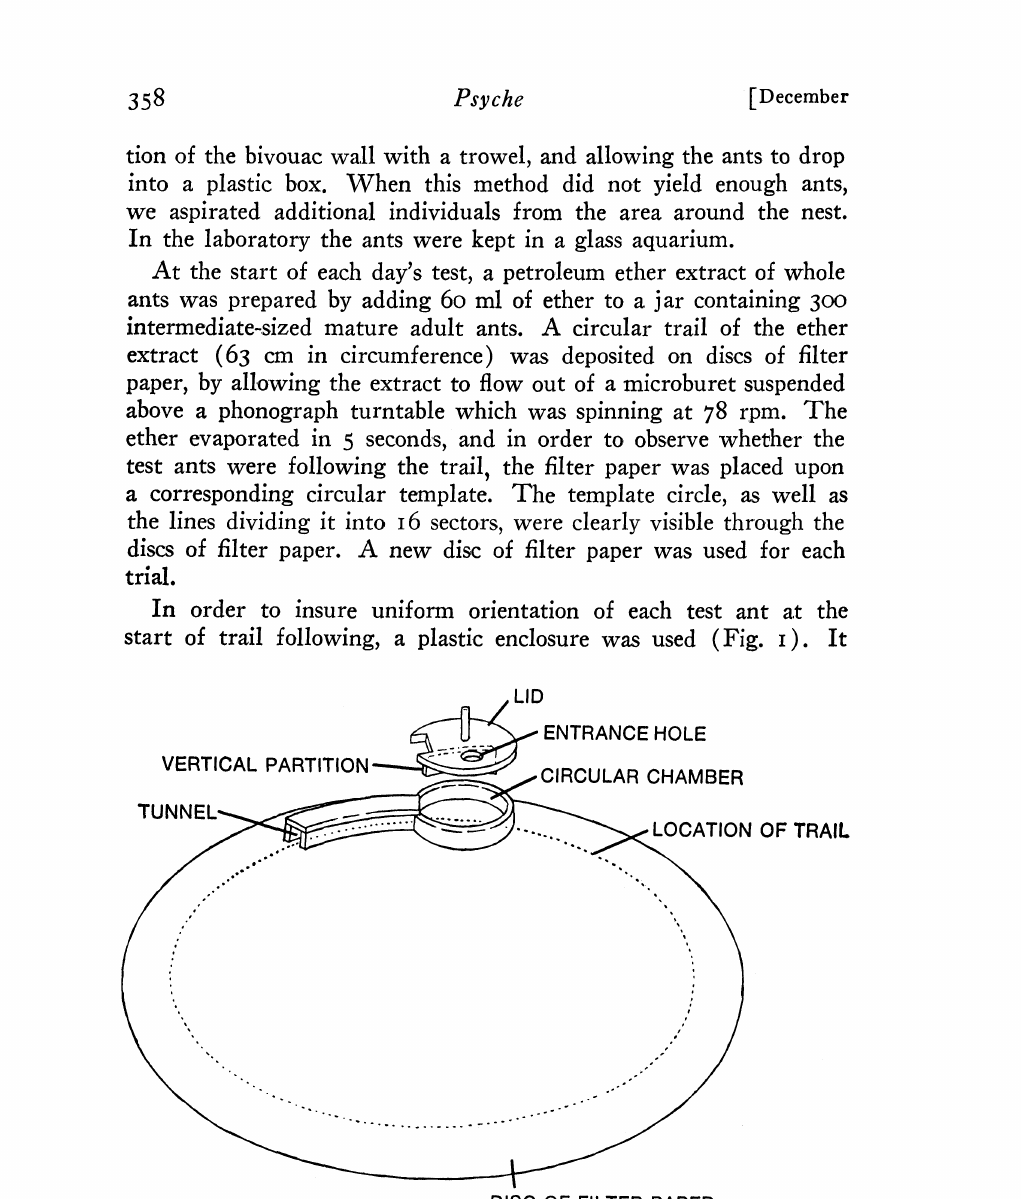
Fig. 1. Apparatus used to insure that all test ants initially orient to the trail in an identical manner. For explanation, see